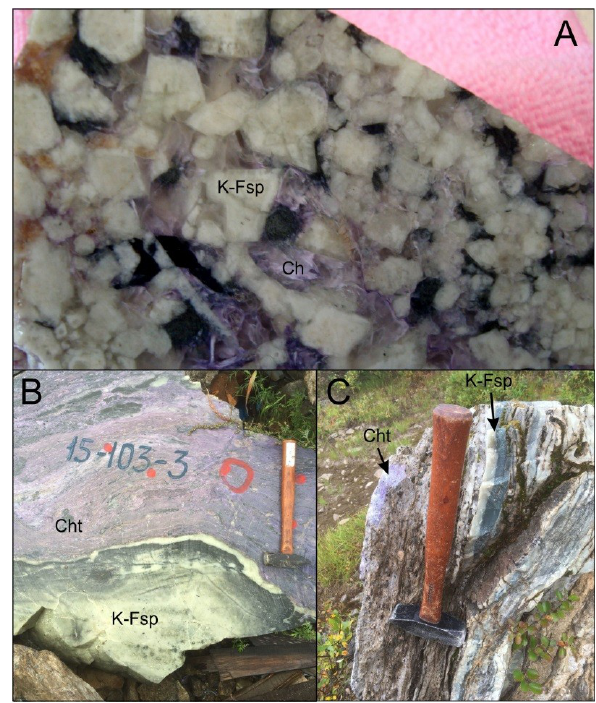
Figure 4. Different types of K-feldspar-bearing (microcline) rocks: ( A ) A polished hand specimen (~20 cm in long direction) of granular microcline (K-Fsp) in intergrowth with charoite (Ch); ( B ) a large xenolith of a massive monomineralic microcline rock (K-Fsp) within a charoitite (Cht) cut-block; ( C ) interlayering of white and dark green microcline veins (K-Fsp) with charoitite (Cht) in a natural outcrop. Reactional snow-white microcline is seen between massive microcline and charoitite in ( B ). A hammer with a 50-cm long handle is shown in ( B , C ) for the scale.